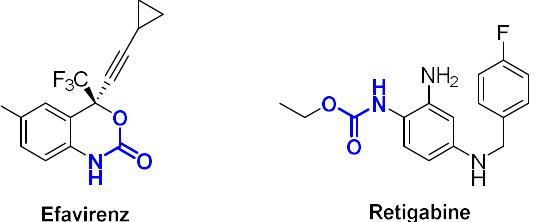
Figure 7. Structures of efavirenz (component of first-line antiretroviral therapy) [138] and retigabine (anticonvulsant medication) [139].